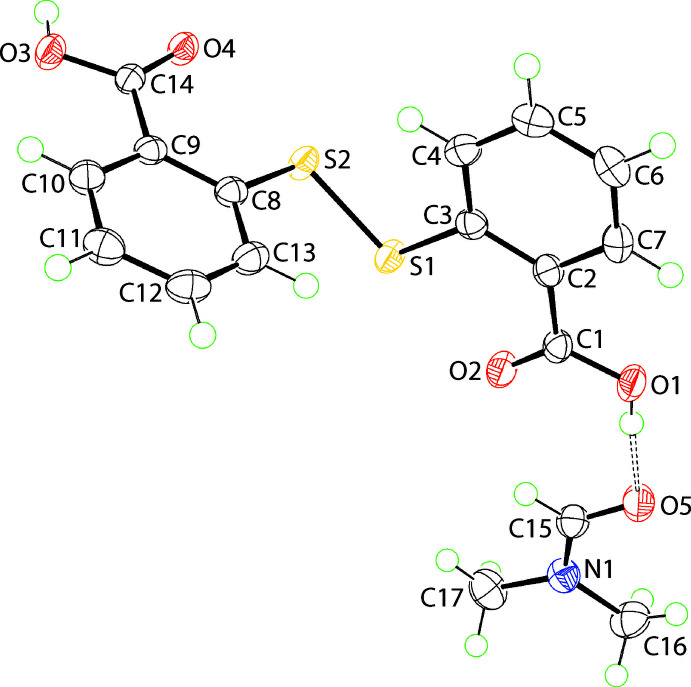
The mol­ecular structures of the constituents of (I) showing the atom-labelling scheme and displacement ellipsoids at the 70% probability level. The dashed line indicates a hydrogen bond.